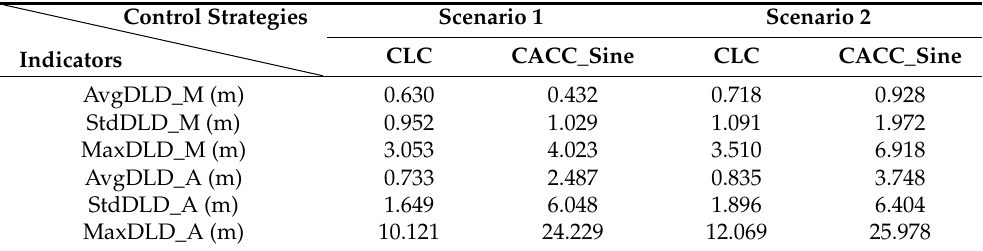
Table 2. Indicator comparison for longitudinal distance of two control strategies.